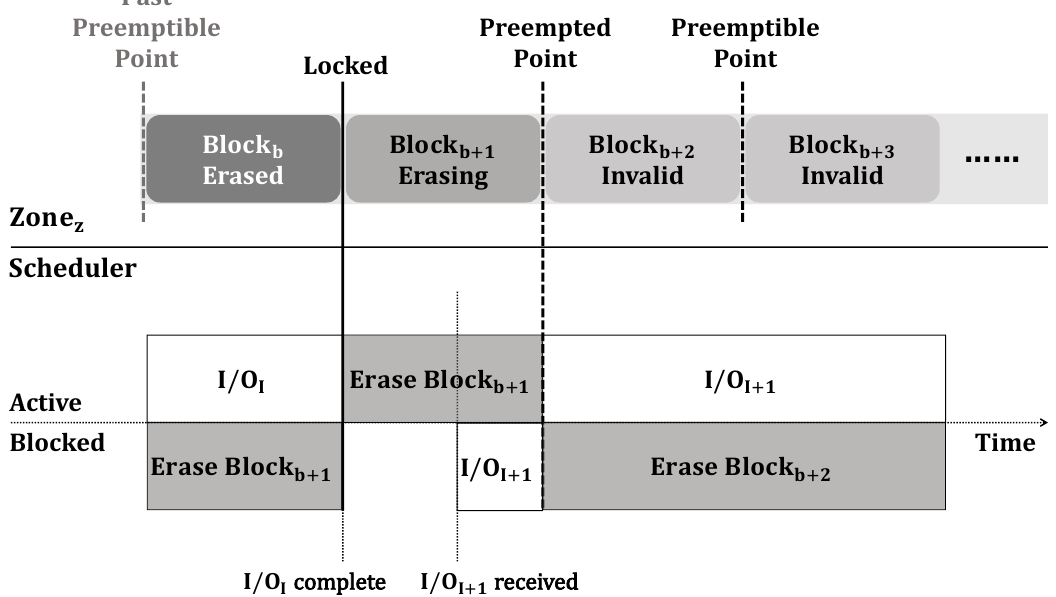
Figure 4. Partial Zone Erase